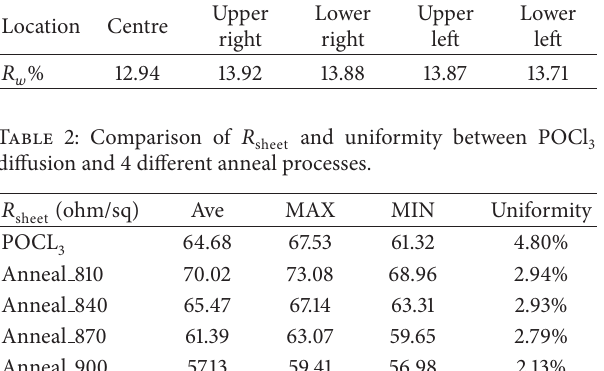
Table 1: Comparison of 𝑅 𝑤 % of five different locations within the wafer.